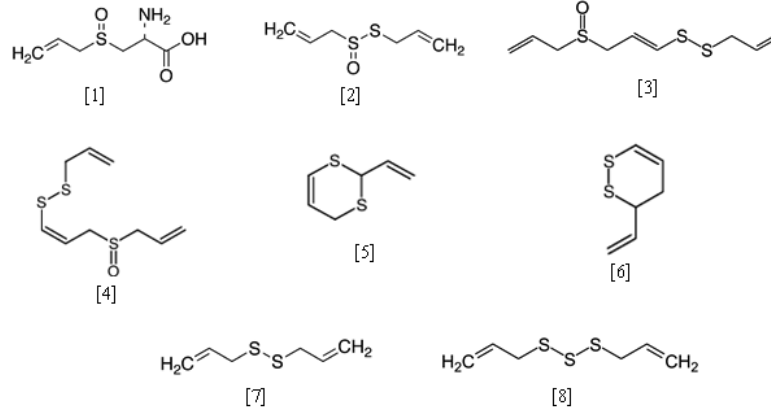
Fig. 2: The chemical structures of sulphur-containing compounds found in